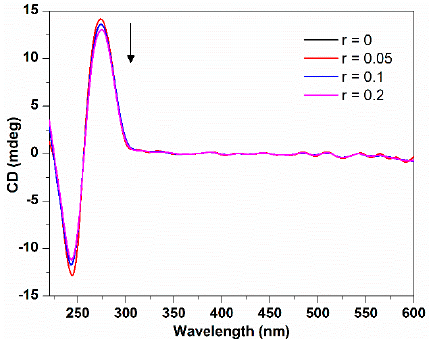
Figure 3. CD spectra changes of ct-DNA (150 μ M) with the addition of TCPC ( r = [TCPC]/[DNA] = 0, 0.05, 0.1, 0.2) in Buffer I.